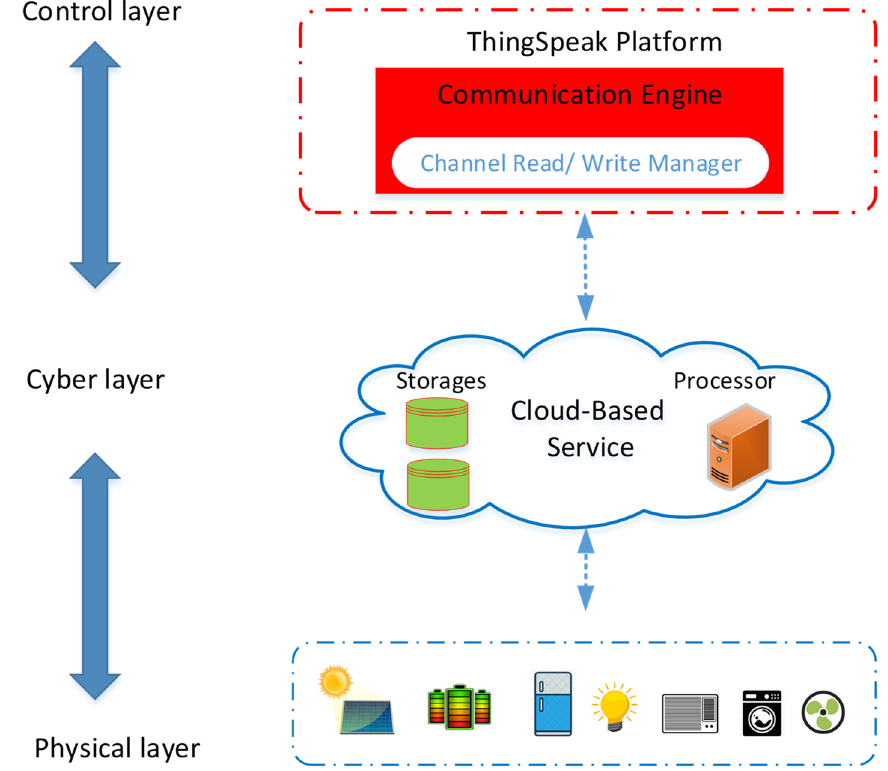
Figure 7. Communication building of the suggested system.